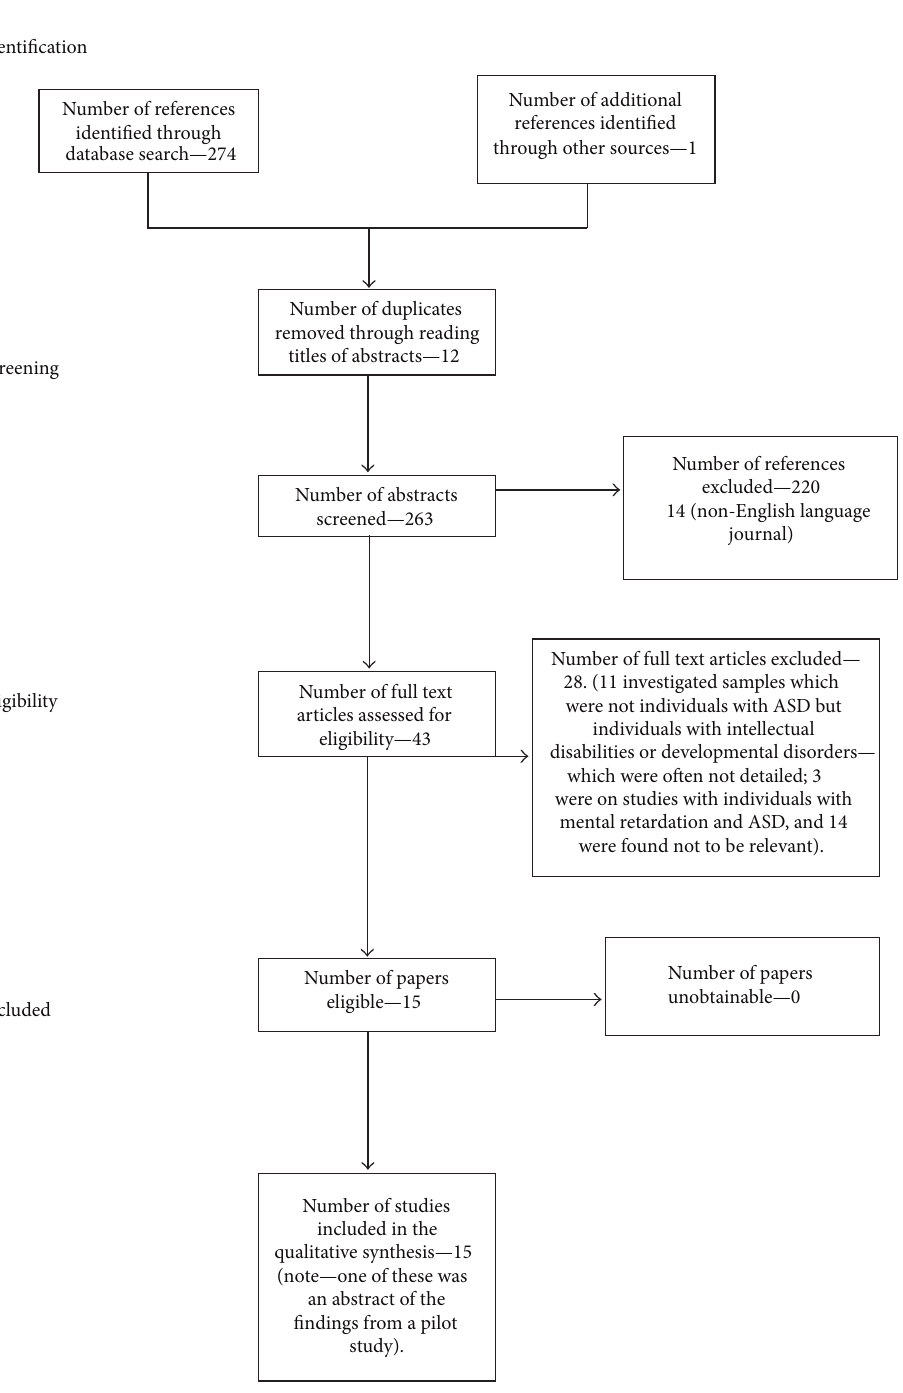
Figure 1: Flow of information through Systematic